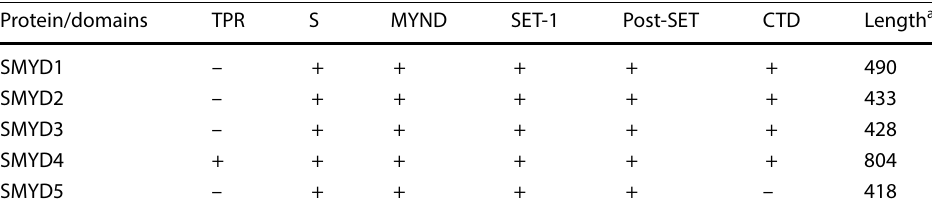
The rightest column is the full length of each protein with amino acid residues. The present data is adapted from